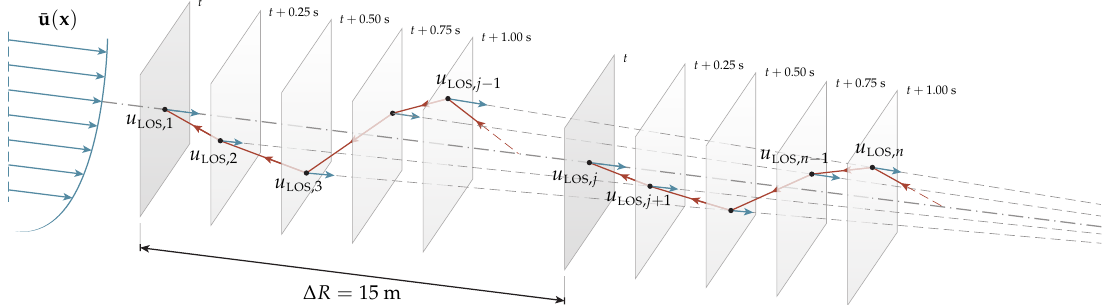
Figure 2. A collection of line-of-sight velocities measured within a certain time period. The distance between the range gates is ∆ R = 15 m. Every time step, the points advect downstream with a mean velocity ¯ u ( x j )